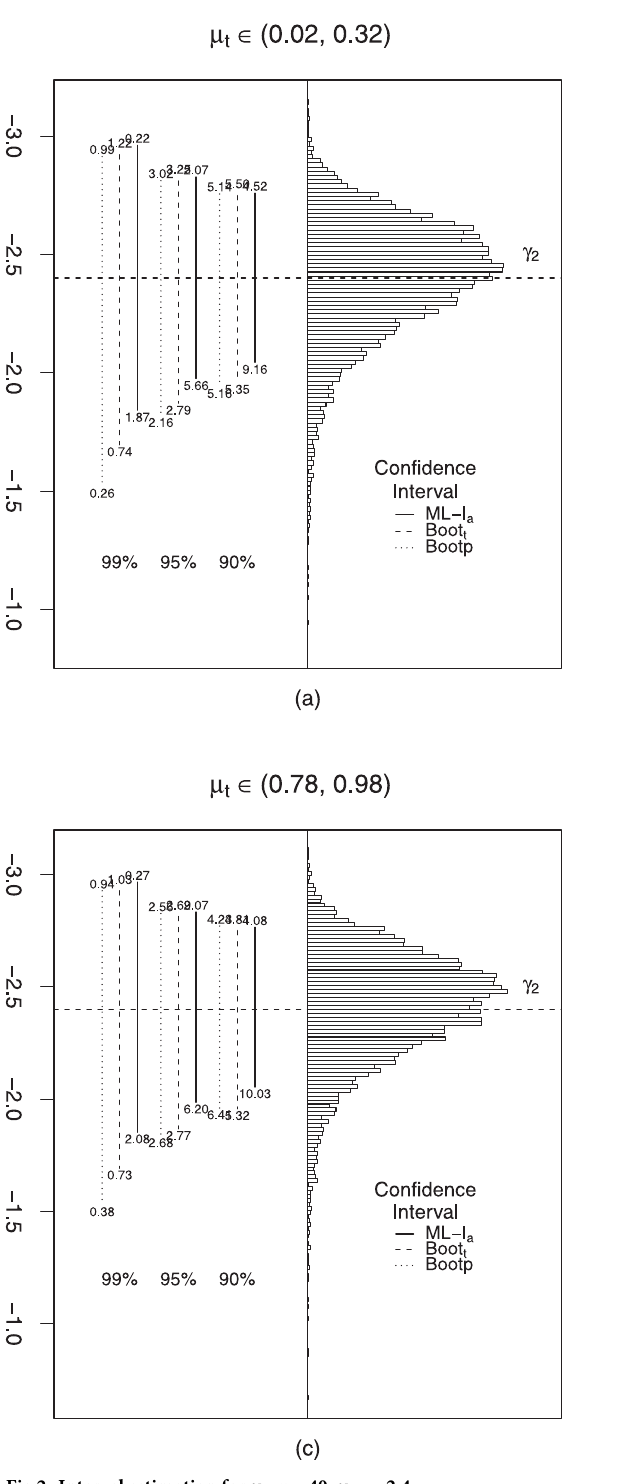
Fig 2. Interval estimation for γ 2 , n = 40. γ 2 = − 2.4.